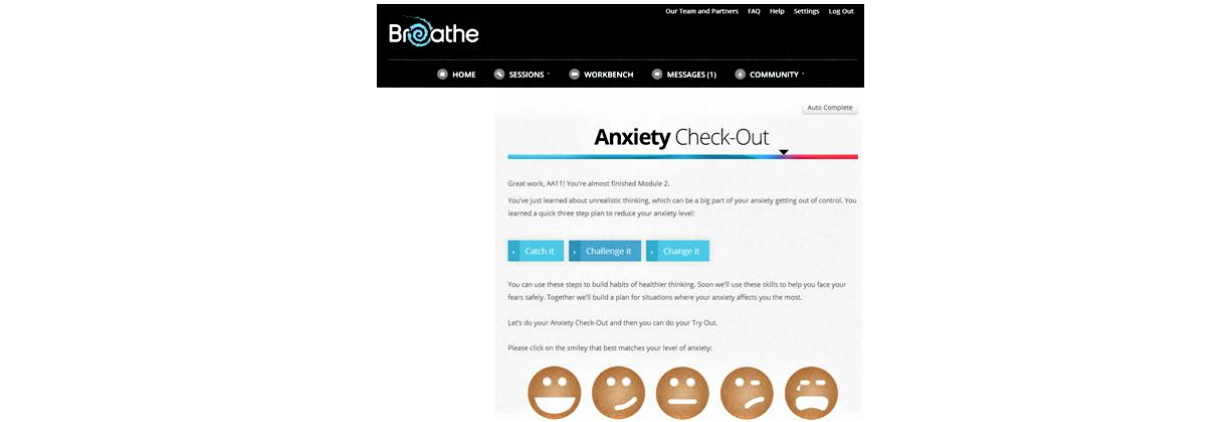
Figure 3. A screenshot of the Check-out activity within the Breathe program.